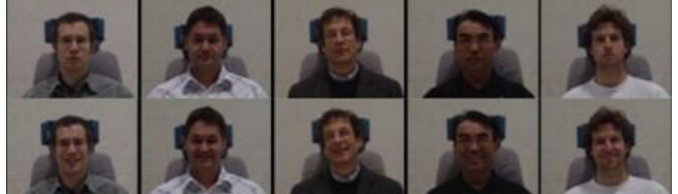
Figure 5. Original Multi-PIE dataset.